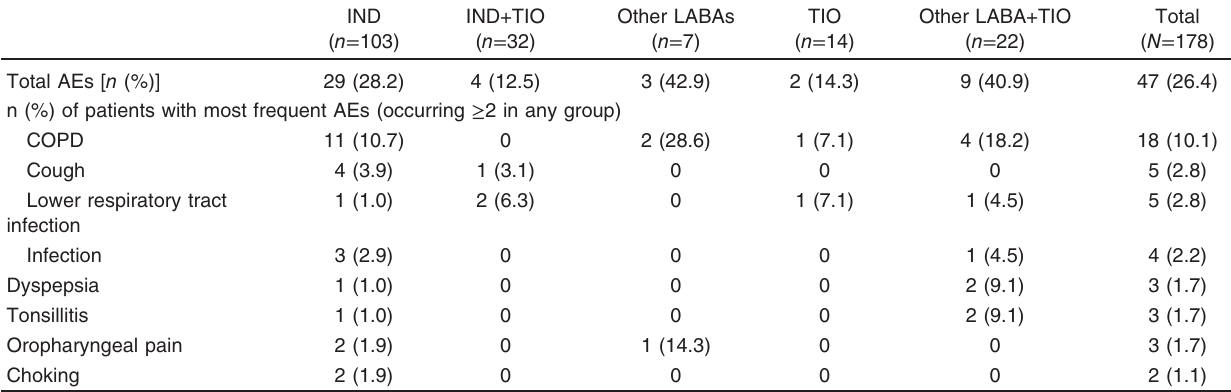
Table 4 Number (%) of patients with adverse events and serious adverse